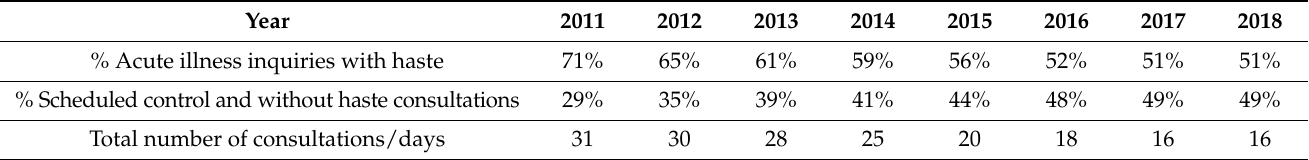
Table 3. Percentage of visits for acute illness in haste and scheduled control without haste in each year.